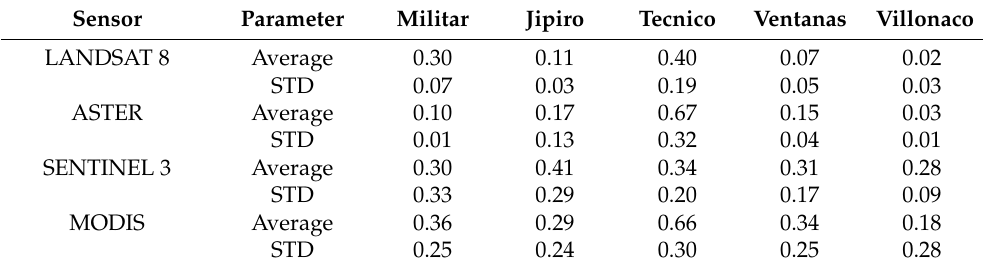
Table 7. Average and standard deviation of the absolute values of the differences between ETo calculated with station data and ETo calculated with remotely sensed data (Table 6), by sensor and